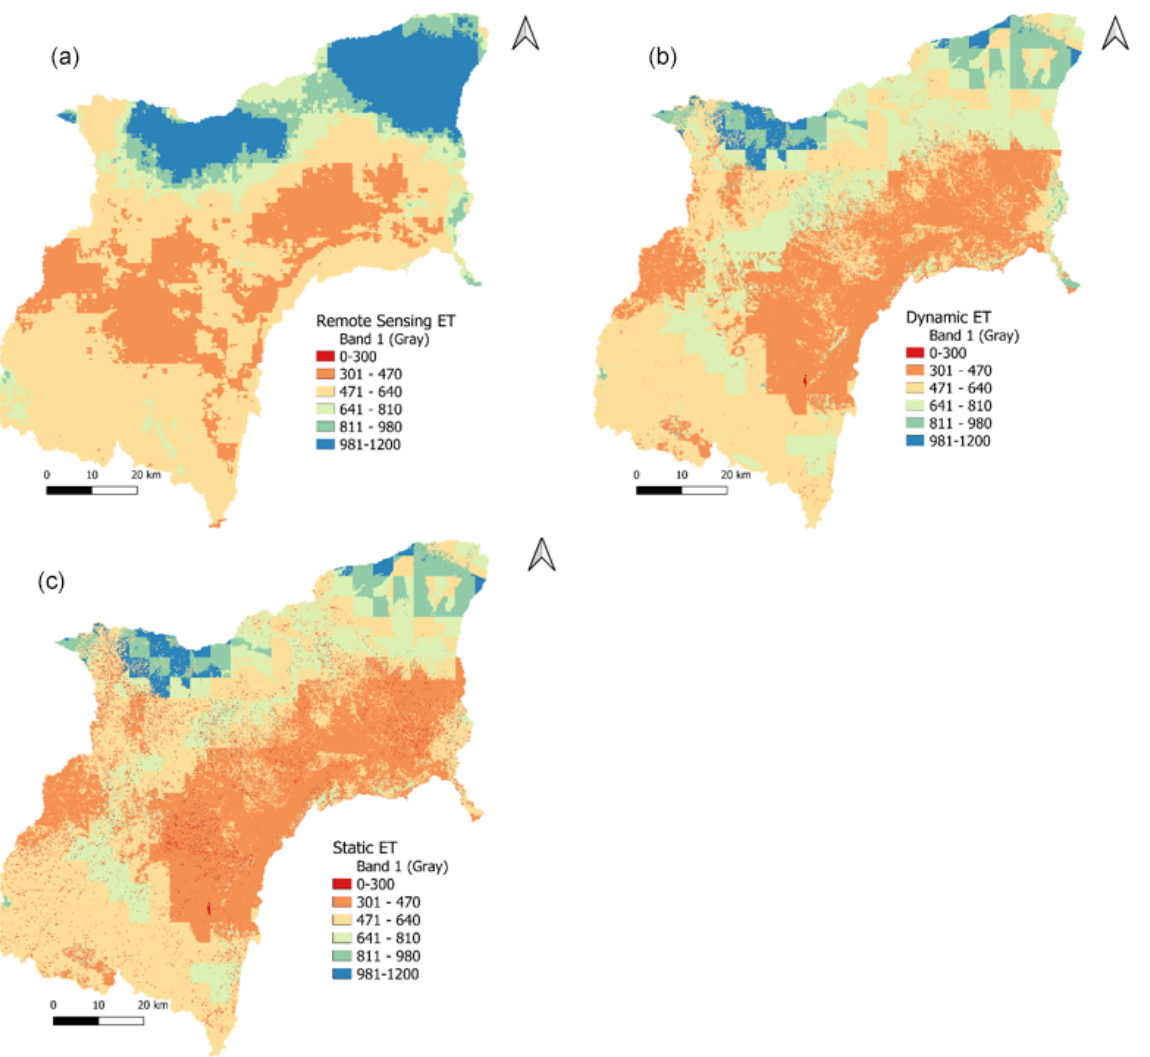
Figure 5. Spatial distribution of ET from (a) remote sensing and the (b) dynamic land use scenario and (c) static land use scenario.